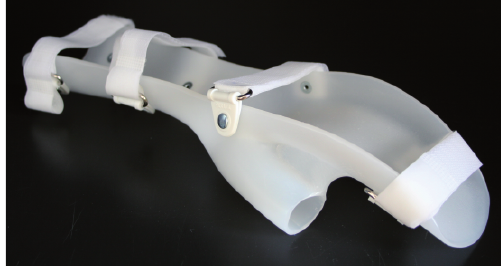
Figure 1: Example of a prefabricated static hand-wrist